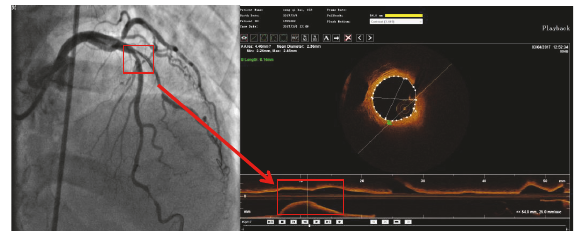
Figure 2: Representative images of lesion plaques analyzed by optical coherence